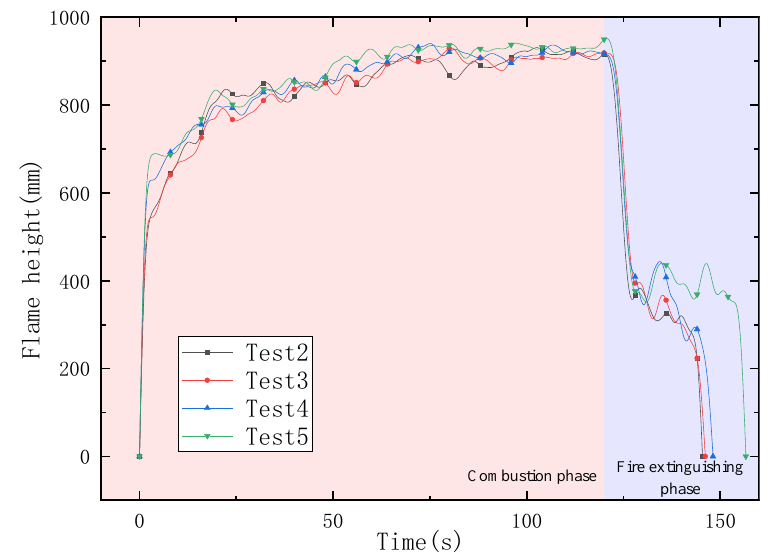
Figure 4. Average flame height under different nitrogen injection flow rates. Table 3. Fire suppression efficiency under different working conditions.